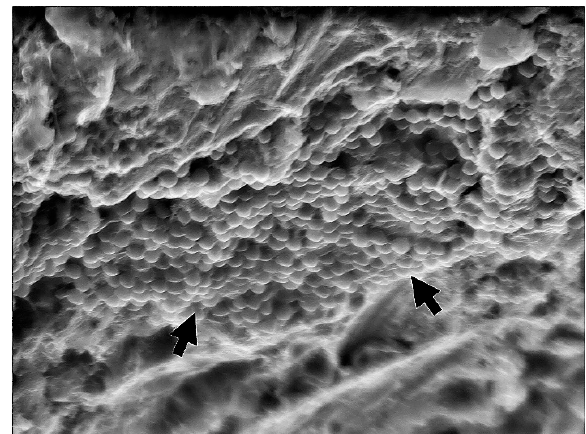
Figure 8. NC group—biofilm formation confirmed using SEM (5000 × )—arrows showing microor- ganism biofilm formation.